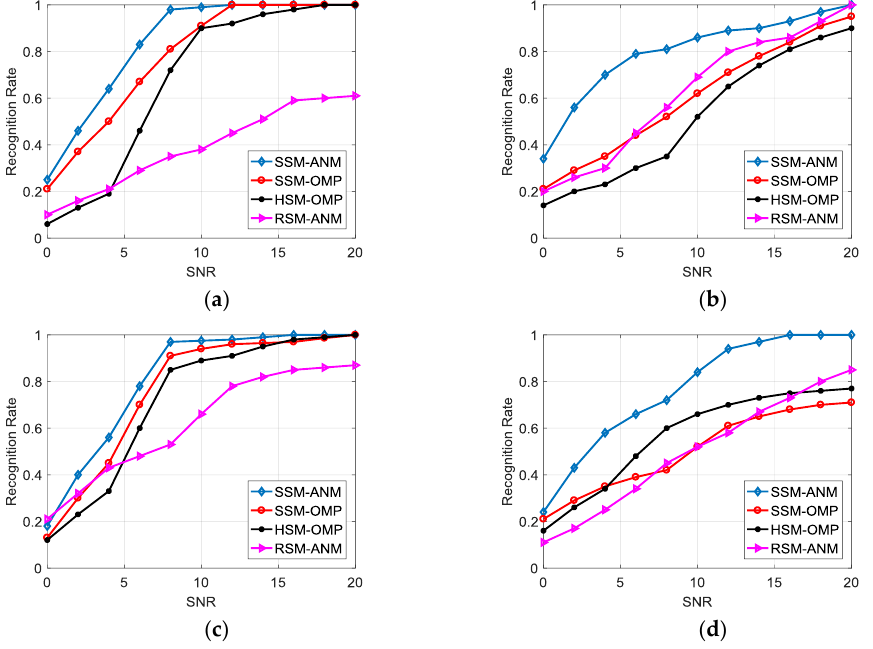
Figure 8. Recognition performance comparison in different SNRs. ( a ) Type A; ( b ) Type B; ( c ) Type C; ( d ) Type D.